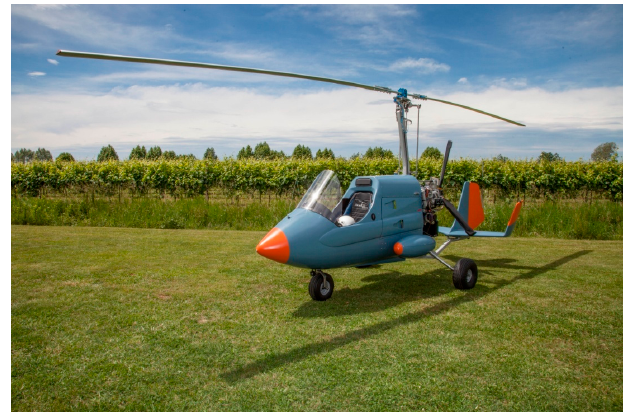
Figure 2. Radgyro, the autogyro used for all the surveys described in Table 1.